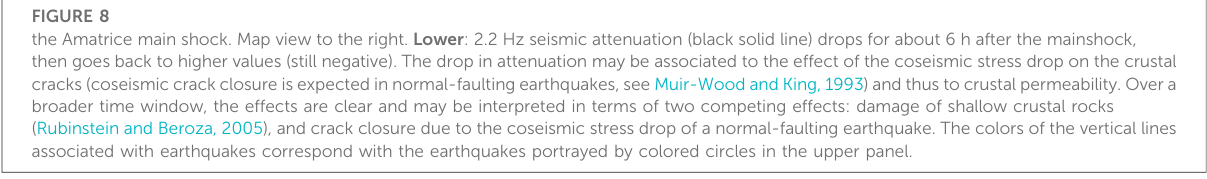
FIGURE 8 the Amatrice main shock. Map view to the right. Lower : 2.2 Hz seismic attenuation (black solid line) drops for about 6 h after the mainshock, then goes back to higher values (still negative). The drop in attenuation may be associated to the effect of the coseismic stress drop on the crustal cracks (coseismic crack closure is expected in normal-faulting earthquakes, see Muir-Wood and King, 1993) and thus to crustal permeability. Over a broader time window, the effects are clear and may be interpreted in terms of two competing effects: damage of shallow crustal rocks (Rubinstein and Beroza, 2005), and crack closure due to the coseismic stress drop of a normal-faulting earthquake. The colors of the vertical lines associated with earthquakes correspond with the earthquakes portrayed by colored circles in the upper